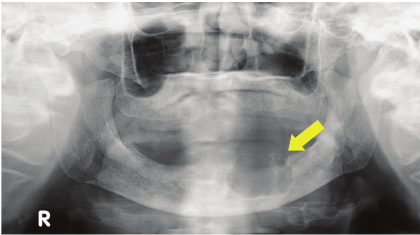
Figure 2: Panoramic X-ray view. A polycystic radiolucent area with an irregular margin can be seen in the molar region of the mandible on the left side.